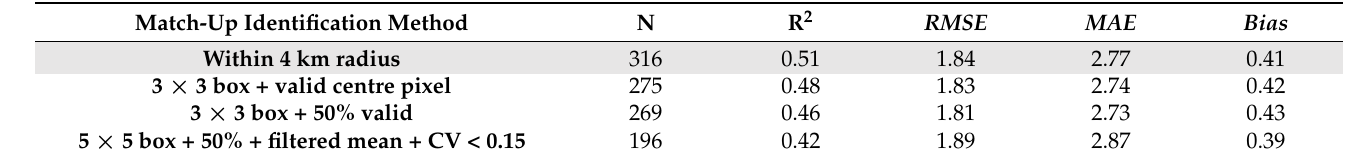
Table 2. Comparison of the overall performance of the CCI 4.2 satellite Chl- a product for each of the four spatial match-up identification methods applied in this